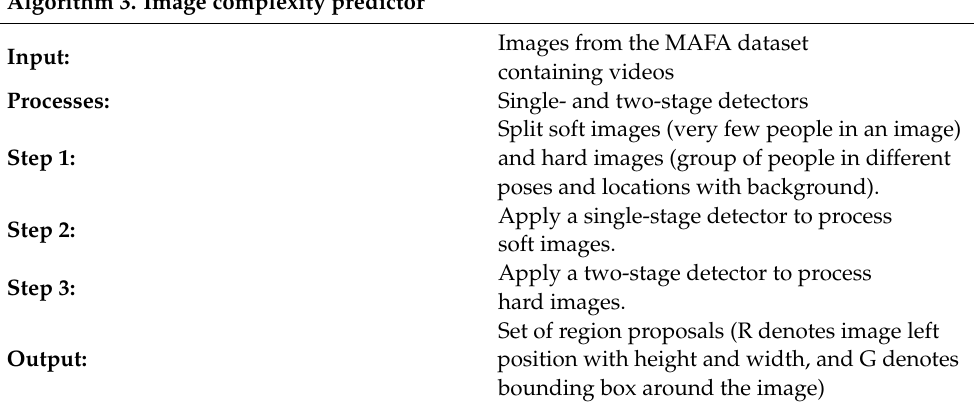
Algorithm 3. Image complexity